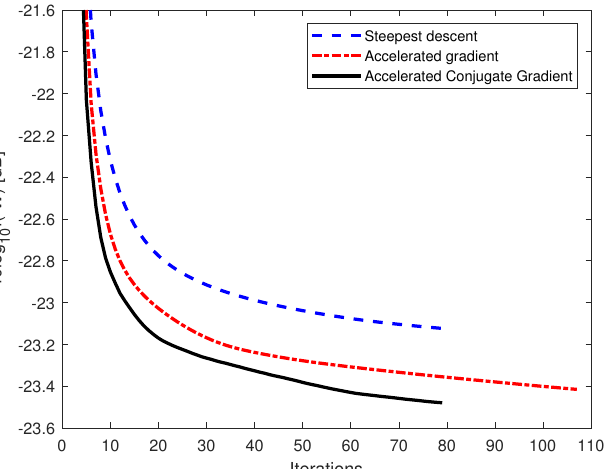
Figure 2. Convergence for simulated room recording data with three microphones and 0dB SNR.